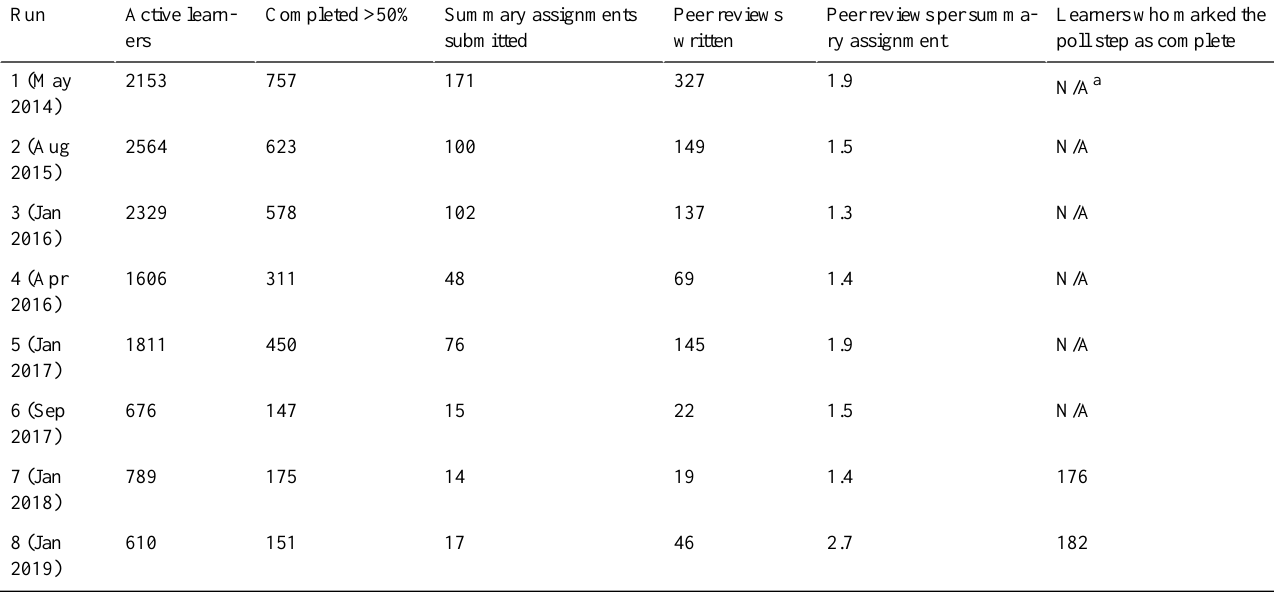
Table 4. Summary of the number of active learners, learners who completed over half the course, assignments submitted, and peer reviews completed for each massive open online course